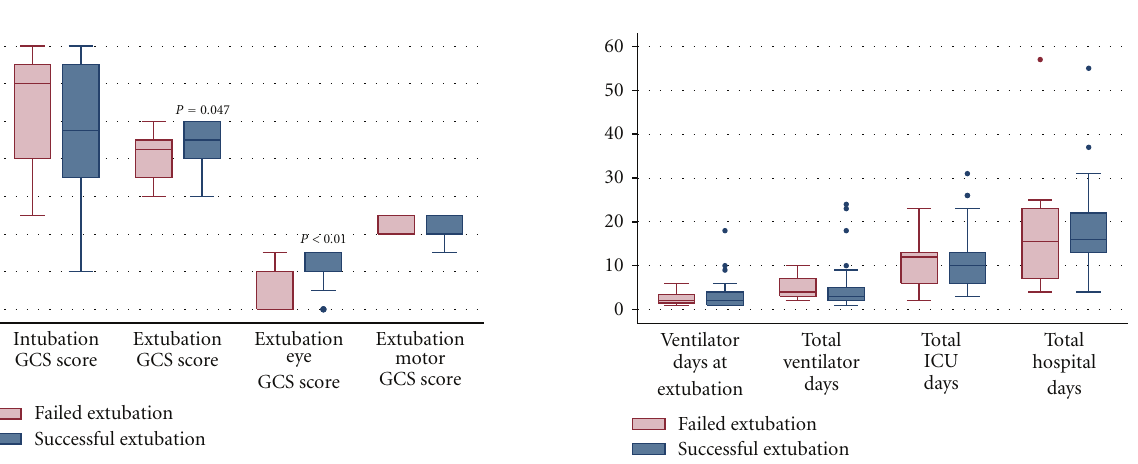
Figure 3: Outcomes of middle cerebral artery acute ischemic stroke patients in whom extubation was successful versus